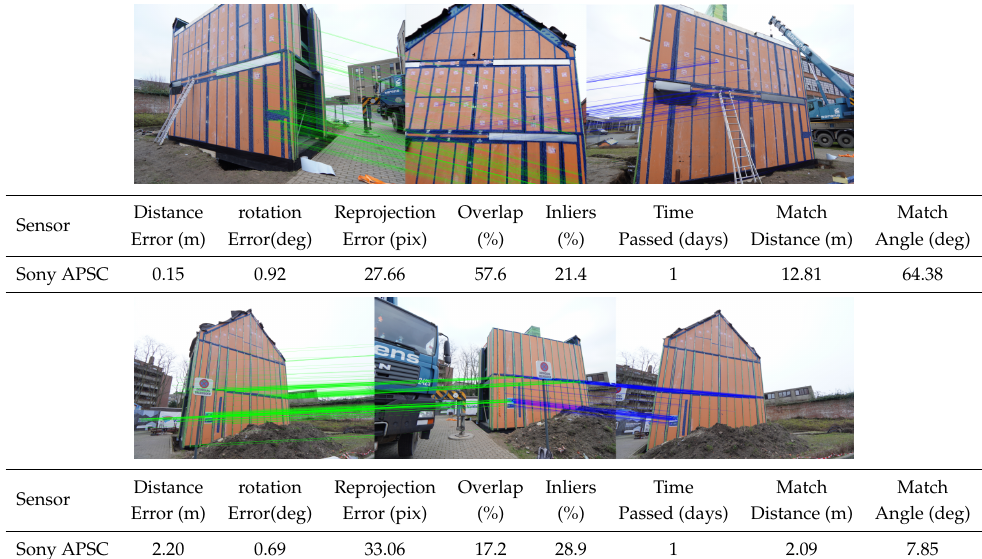
Table 5. Two-dimensional matching estimations based on 2 separate reference